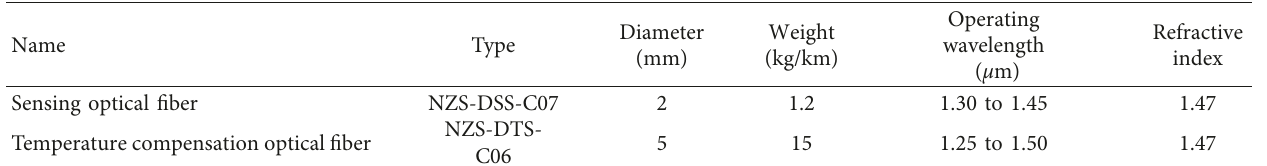
Table 1: Parameters of the optical